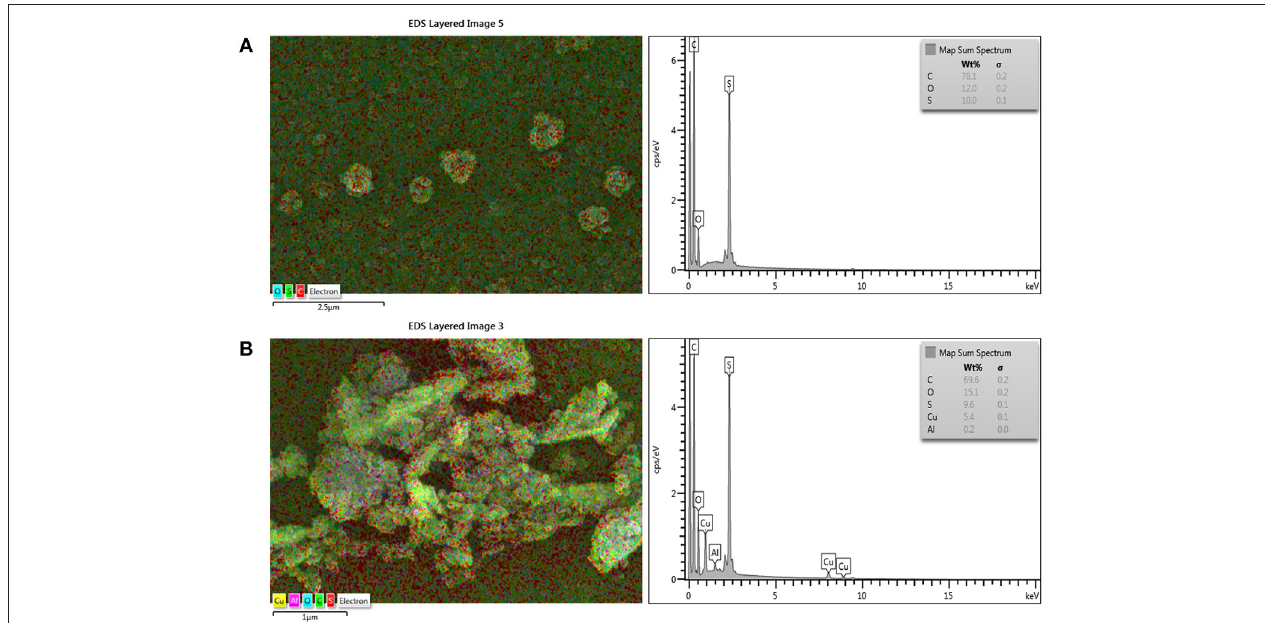
FIGURE 3 | EDX analysis of (A) TFC and (B) TFN 2 membranes.